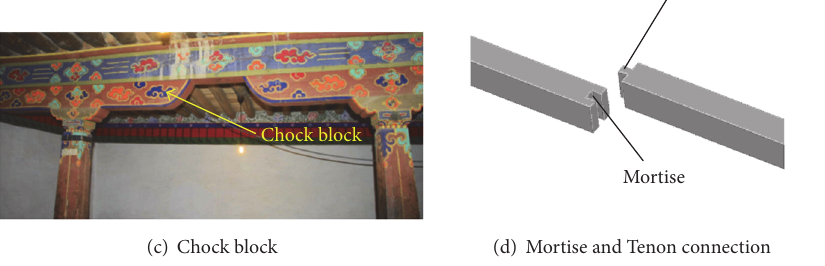
Figure 10: Semirigid beam-column